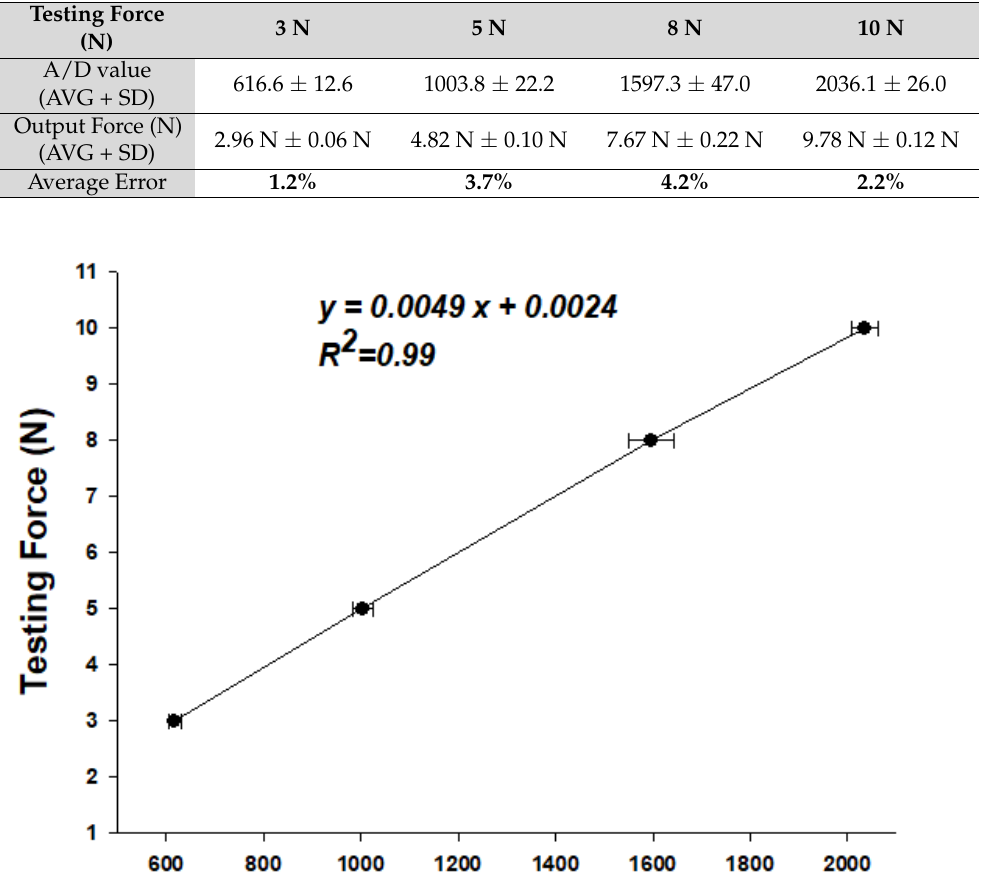
Table 1. Errors of output force calculated by the regression curve equation.